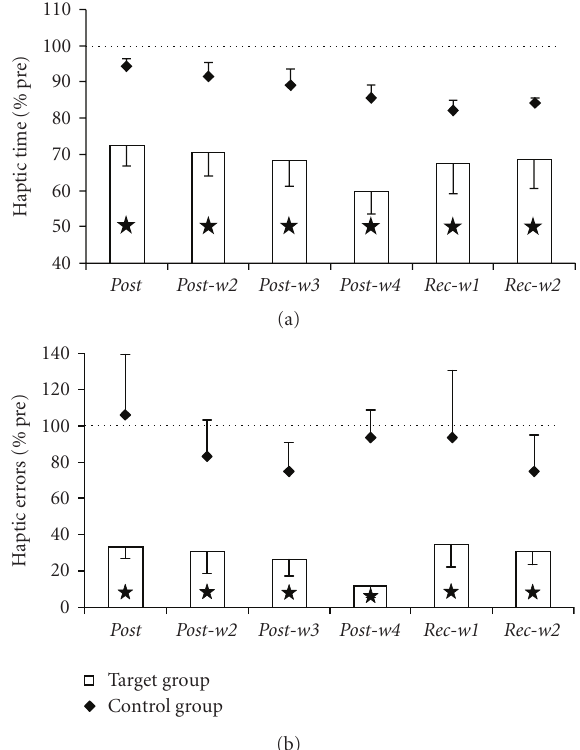
Figure 3: Haptic object recognition skills. (a) Percentage change of the time to fulfill the haptic object recognition test averaged across subjects of the target (bars) and control group (diamonds) relative to their performance in the presession. Stars indicate significant changes ( P ≤ . 05) . (b) Same as (a) for the number of errors in the haptic object recognition